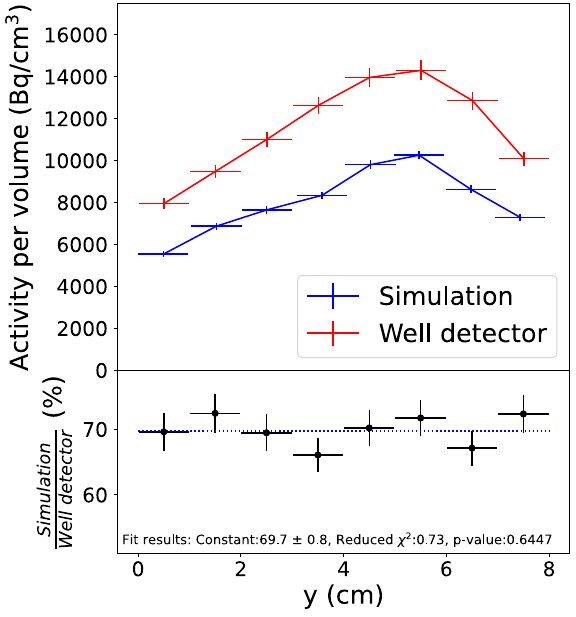
plotting.FIG. 12. Comparison of activity measurements at ANL, using a well-type detector, and FLUKA simulations for Rod 1. Results have been normalized to a reference date of December 14, 2019. The dotted line represents the fit of the ratio between data and